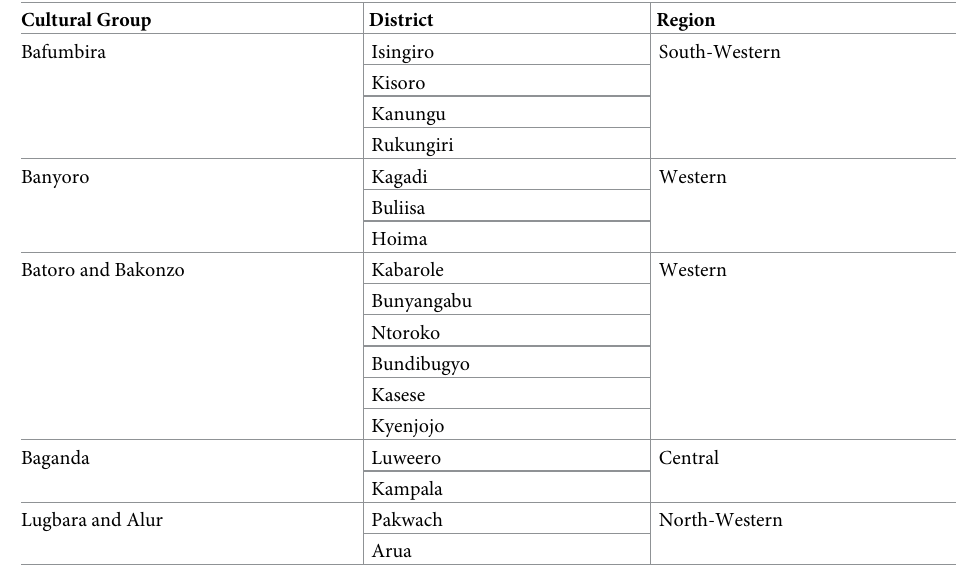
Table 1. Cultural grouping of study